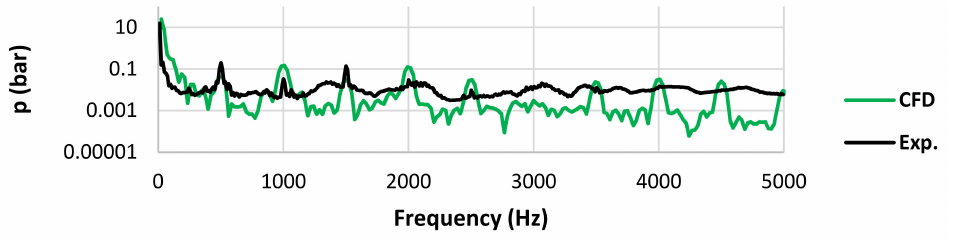
Figure 22. Delivery port pressure ripple FFT analysis obtained from the CFD simulations and the experiment for the IGP at p 2 = 22.5 bar pressure load, 20 ◦ C oil temperature and 2000 rpm.